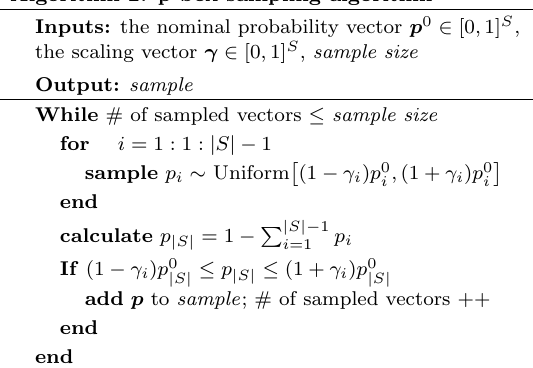
Algorithm 2: p-box sampling algorithm